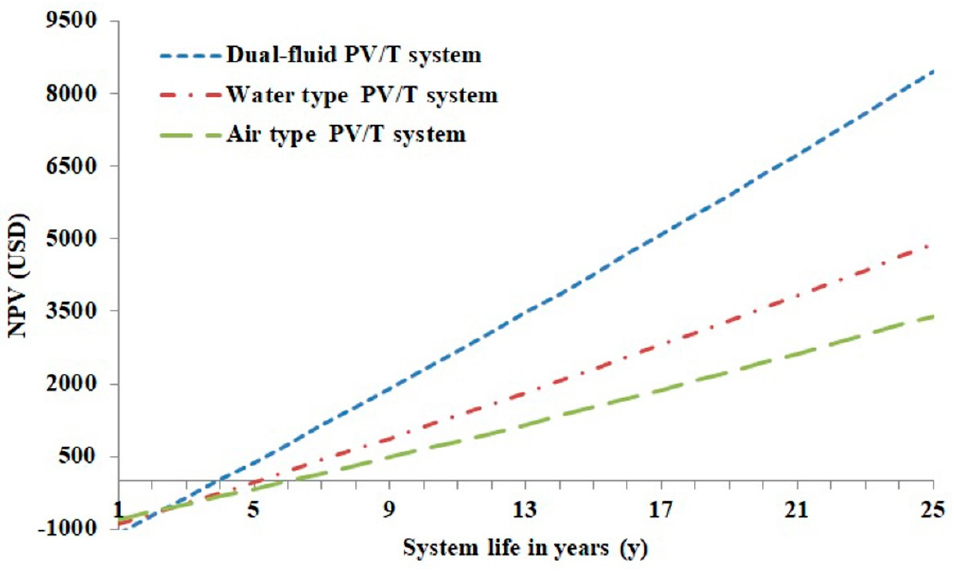
Figure 11. Variations of the net present value (NPV) of the PV/T systems across 25 years.